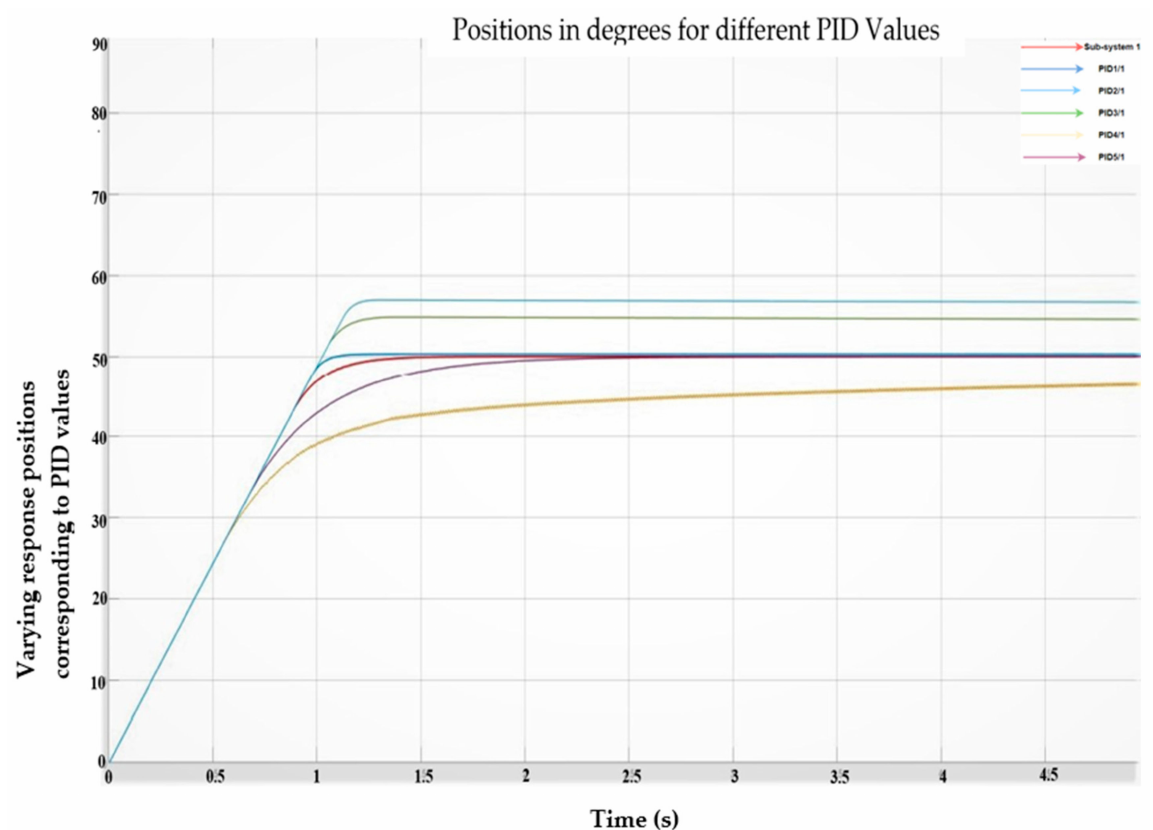
Figure 9. Responses of the actuator for different PID